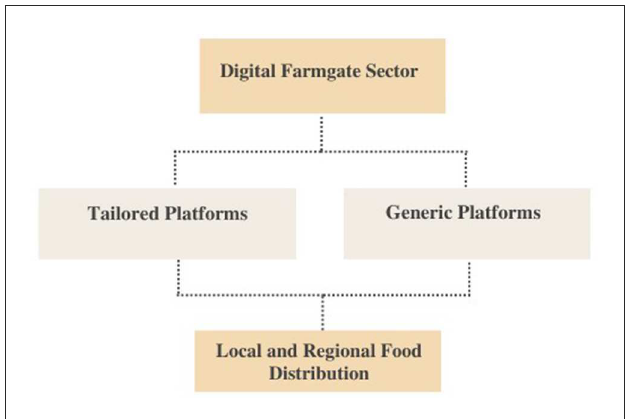
FIGURE1 Digital farmgate sector typology. The digital farmgate sector is part of the broader AEC sector which includes platforms for food sales at broader scales than local or regional (e.g., superstore online shopping